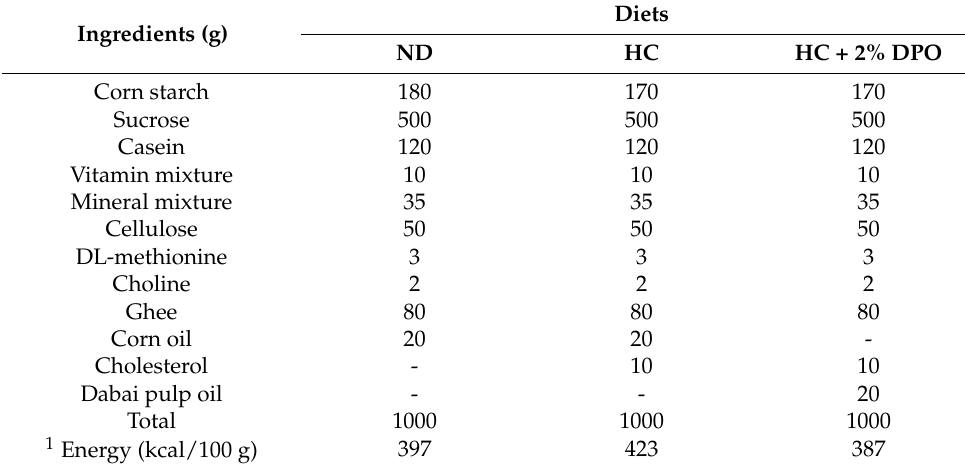
Table 1. Experimental